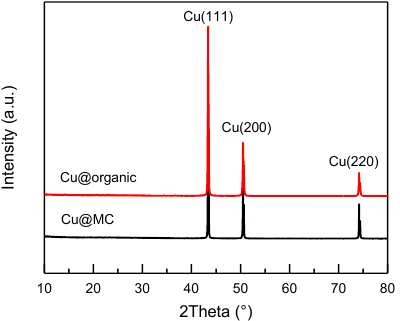
Figure 3. XRD patterns of Cu@organic (red) and Cu@MC (black).